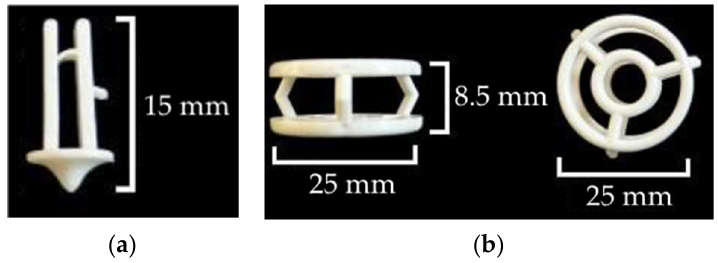
Figure 3. Dimensions of the spacer connections: ( a ) the central pin; ( b ) the circular piece.